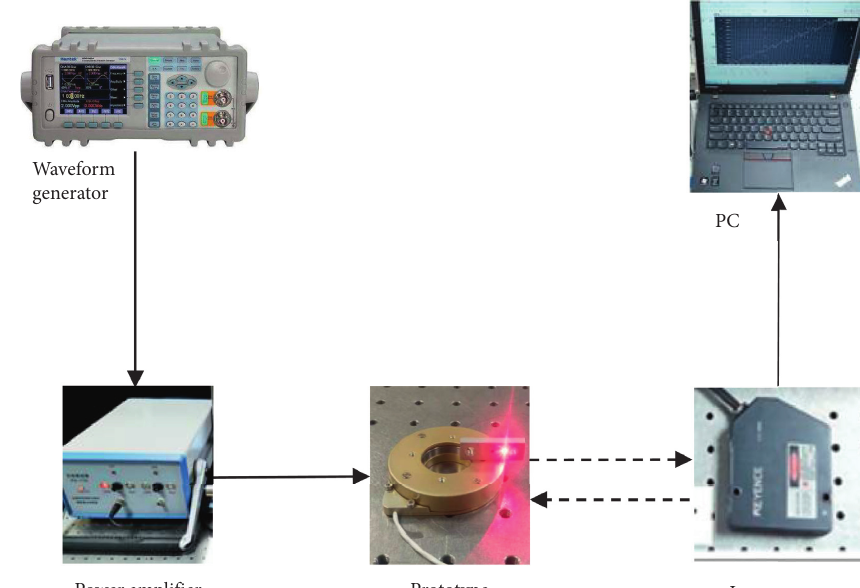
Figure 11: Experiment system.